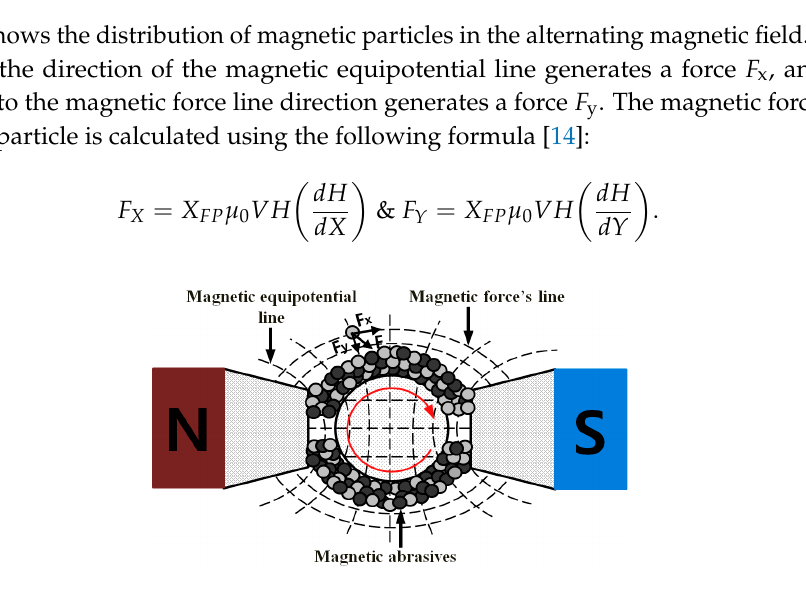
Figure 1. Schematic of the processing principles of cylindrical magnetic abrasive machining.